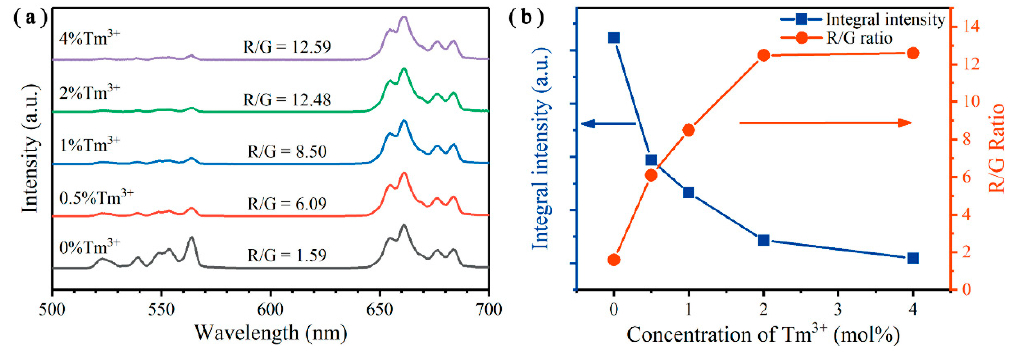
Figure 3. ( a ) Normalized upconversion (UC) emission spectra of Y 2 O 3 :Er 3+ /Tm 3+ (8/ x mol%) UCNPs. ( b ) Integral luminescence intensities (from 500 to 700 nm) and red-to-green (R/G) ratios of the Y 2 O 3 :Er 3+ /Tm 3+ UCNPs doped with different concentrations of Tm 3+ ions. All excited by a 980 nm laser at an excitation intensity of 341 W cm − 2 .